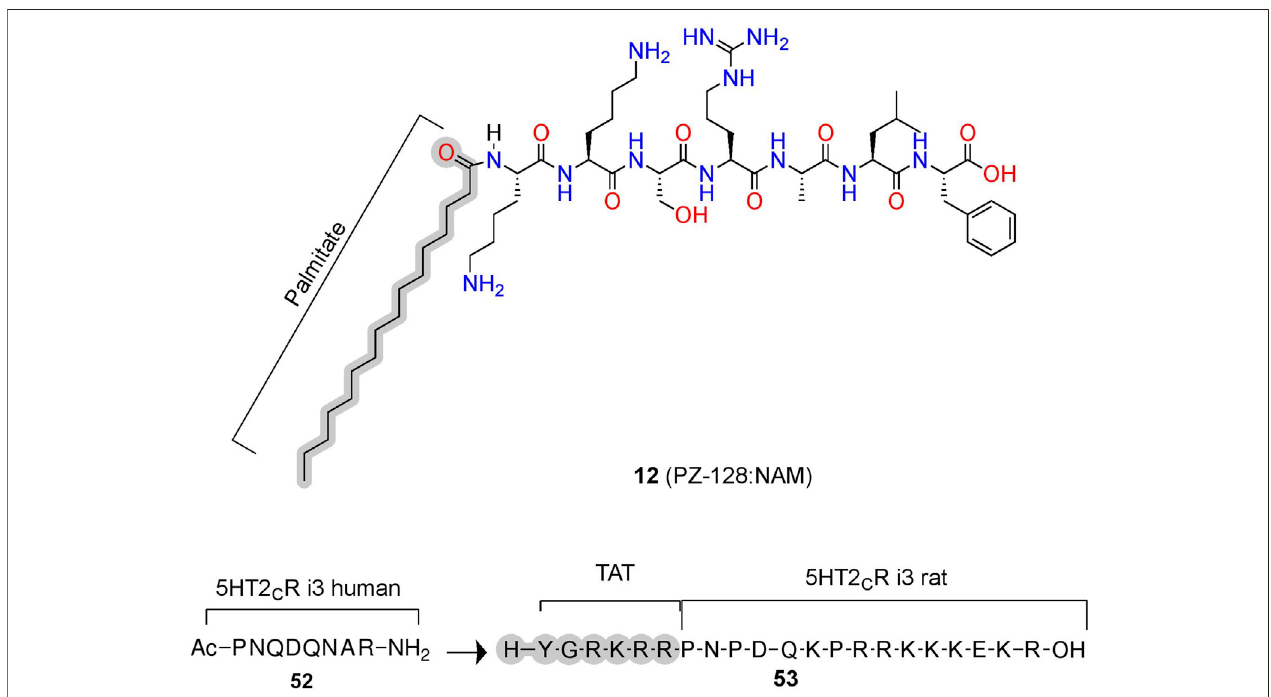
FIGURE11| PeptideconjugationstoimprovephysicochemicalpropertiesofpepducinsatPAR1and5-HT 2C .ExampleofpepducinsderivedfortheICLsequences that are unconjugated (acetyl) or conjugated to a palmitate- or cell-penetrating sequence (e.g., TAT). The in-text compound number is bold, followed by original name: activity. Structures were originally reported by Ji et al., 2006 and Anastasio et al., 2013. Figure was created with Chemdraw20.0, MarvinSketch, 5 and Molecular Operating Environment (MOE). 2